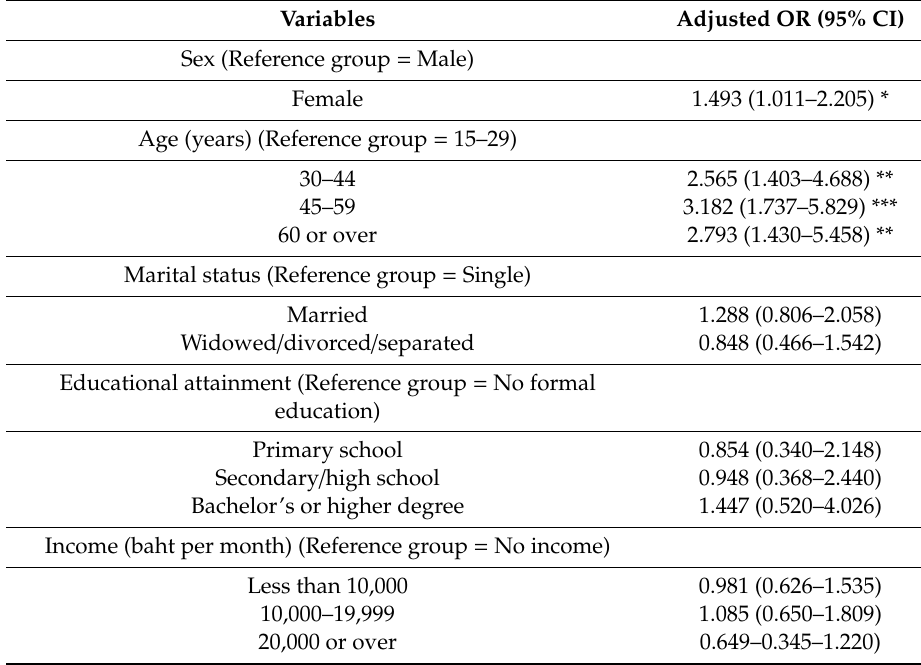
Table 4. Binary logistic regression of socio-demographic characteristics and health-related behaviors in association with practicing urban home gardening ( N =